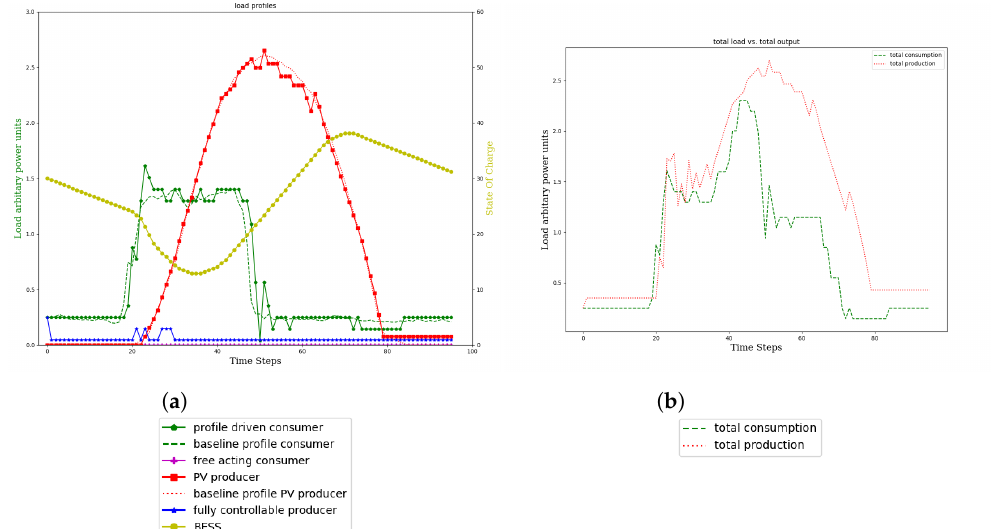
Figure 10. Evaluation on day 2, with agents trained on day 1. ( a ) Agent load curves and profiles. ( b ) Load